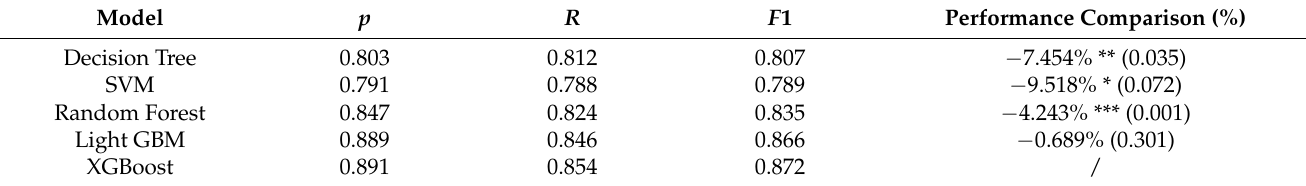
Table 4. Comparisons of proposed method with other mainstream methods (10-fold average).